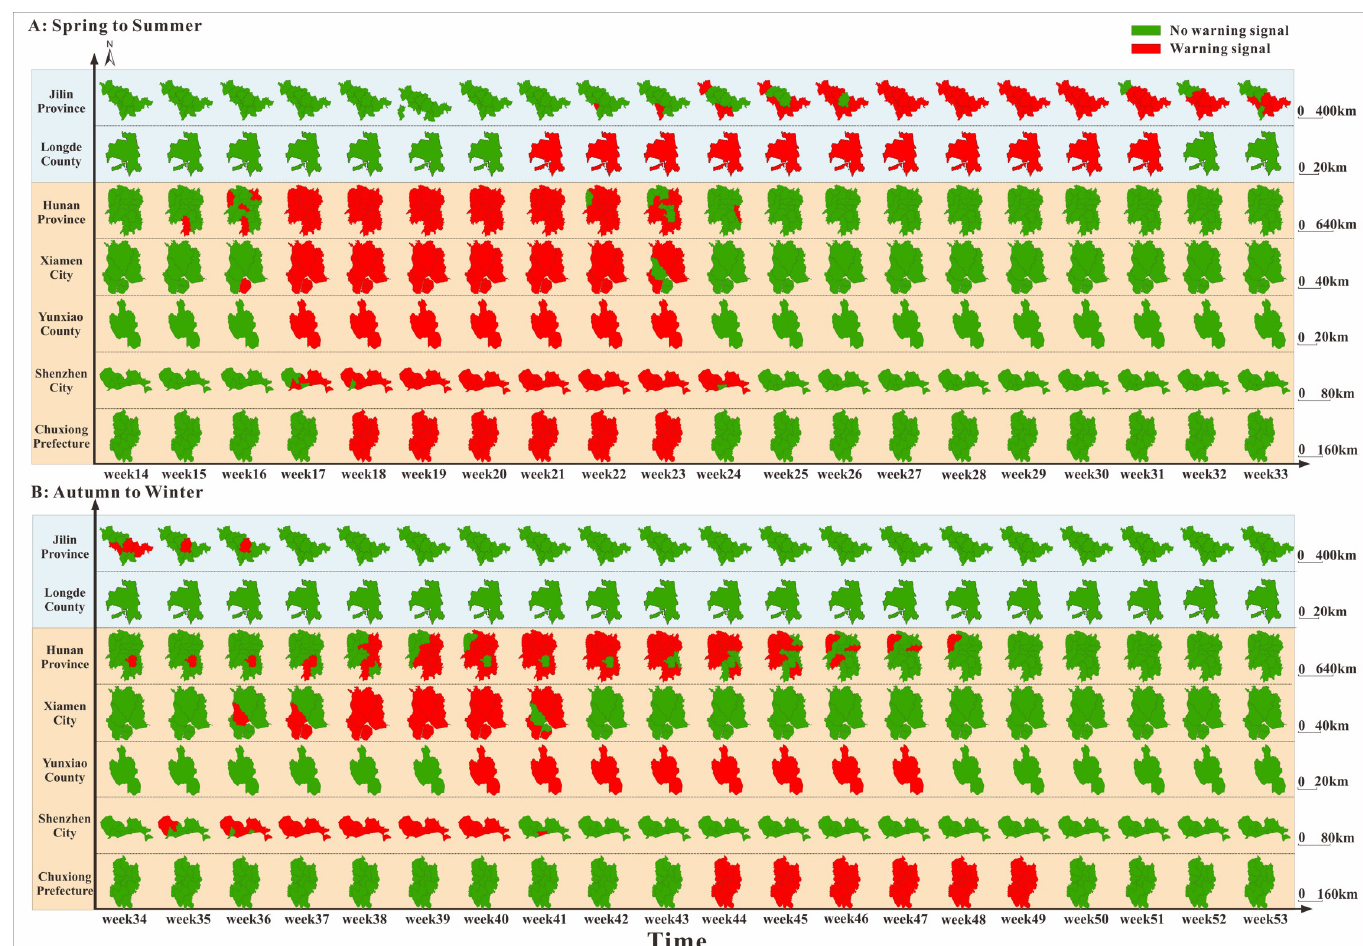
Fig 13. Time and space warning map in Hunan Province, Jilin Province, Shenzhen City, Xiamen City, Chuxiong Prefecture, Yunxiao County, and Longde County. The warning signals in this figure were median early warning week of each area. (A: Spring to Summer; B: Autumn to Winter; Red signals represent that the epidemic is in the accelerated period and indicate the beginning of early warning, and green signals represent that the epidemic is in the deceleration period, meaning that the early warning can be subsequently relieved.) The map depicted in this figure was taken from Wikimedia Commons https://commons.wikimedia.org/wiki/Atlas_of_the_People %27s_Republic_of_China#/media/File:China_Hunan.svg.